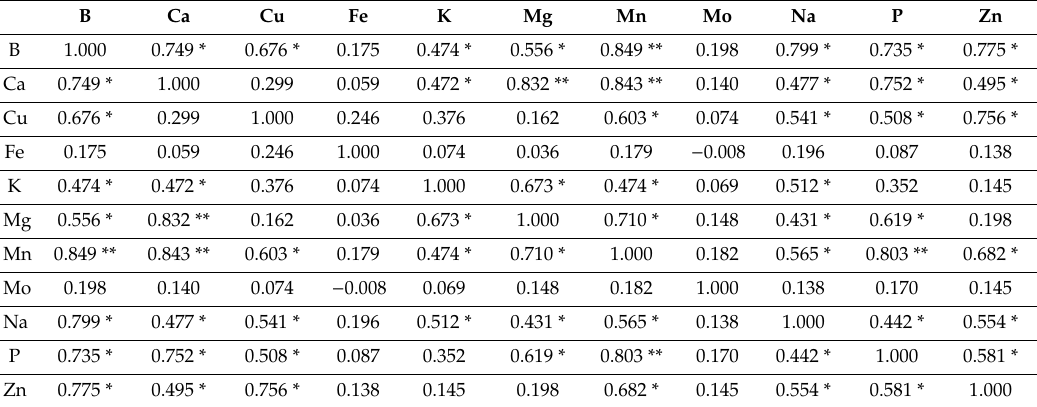
Table 1. Correlation matrix for elements in the rind. Statistical analysis was performed using SPSS 25.0.0.1. Correlations greater than 0.900 were considered very strong and are marked with ***. Correlations between 0.700 and 0.899 were considered strong correlation and are marked with **. Correlations between 0.400 and 0.699 were considered moderate correlation and are marked with *. Correlations between 0 and 0.399 were considered weak correlation and are not marked. The KMO test score was 0.828. Bartlett’s test score was 0. Each element corresponds to independent measurements and 108 individual analyses.